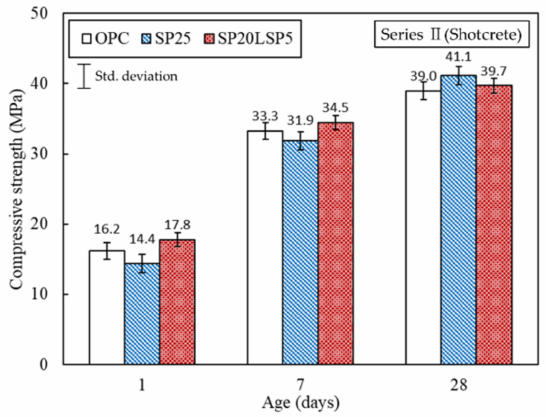
Figure 7. Compressive strength of